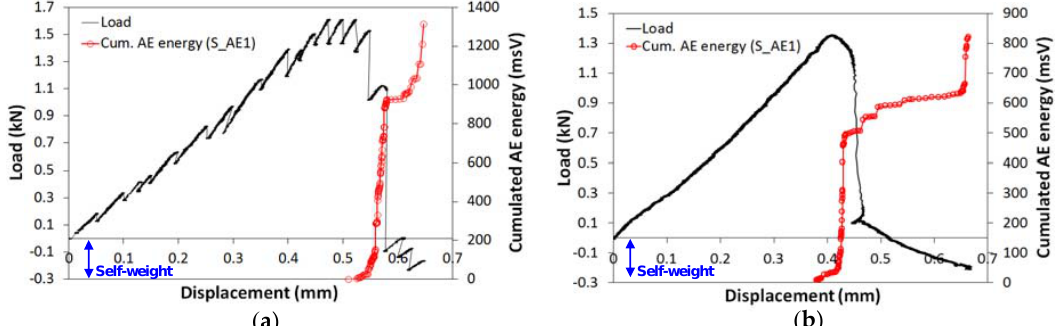
Figure 8. Load and cumulated AE energy vs. displacement diagrams for ( a ) test 2 and ( b ) test 3 (S AE1 = wideband sensor).